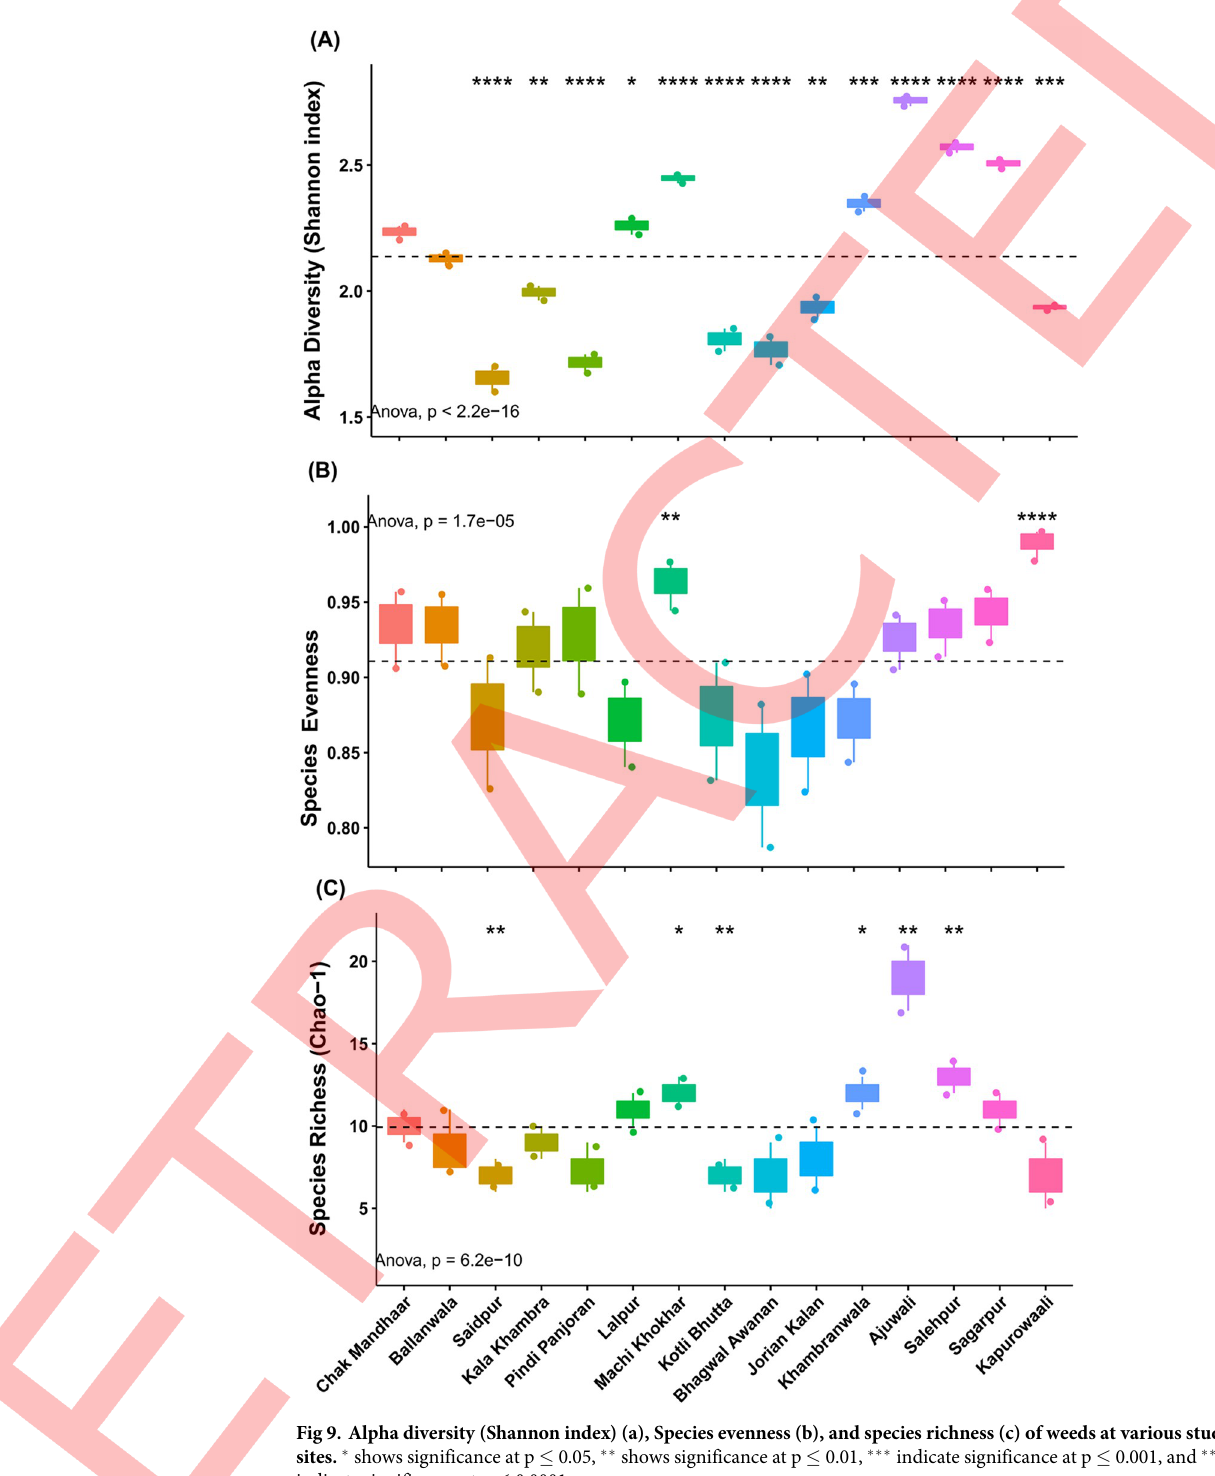
Fig 9. Alpha diversity (Shannon index) (a), Species evenness (b), and species richness (c) of weeds at various study sites. � shows significance at p � 0.05, �� shows significance at p � 0.01, ��� indicate significance at p � 0.001, and ���� indicate significance at p �